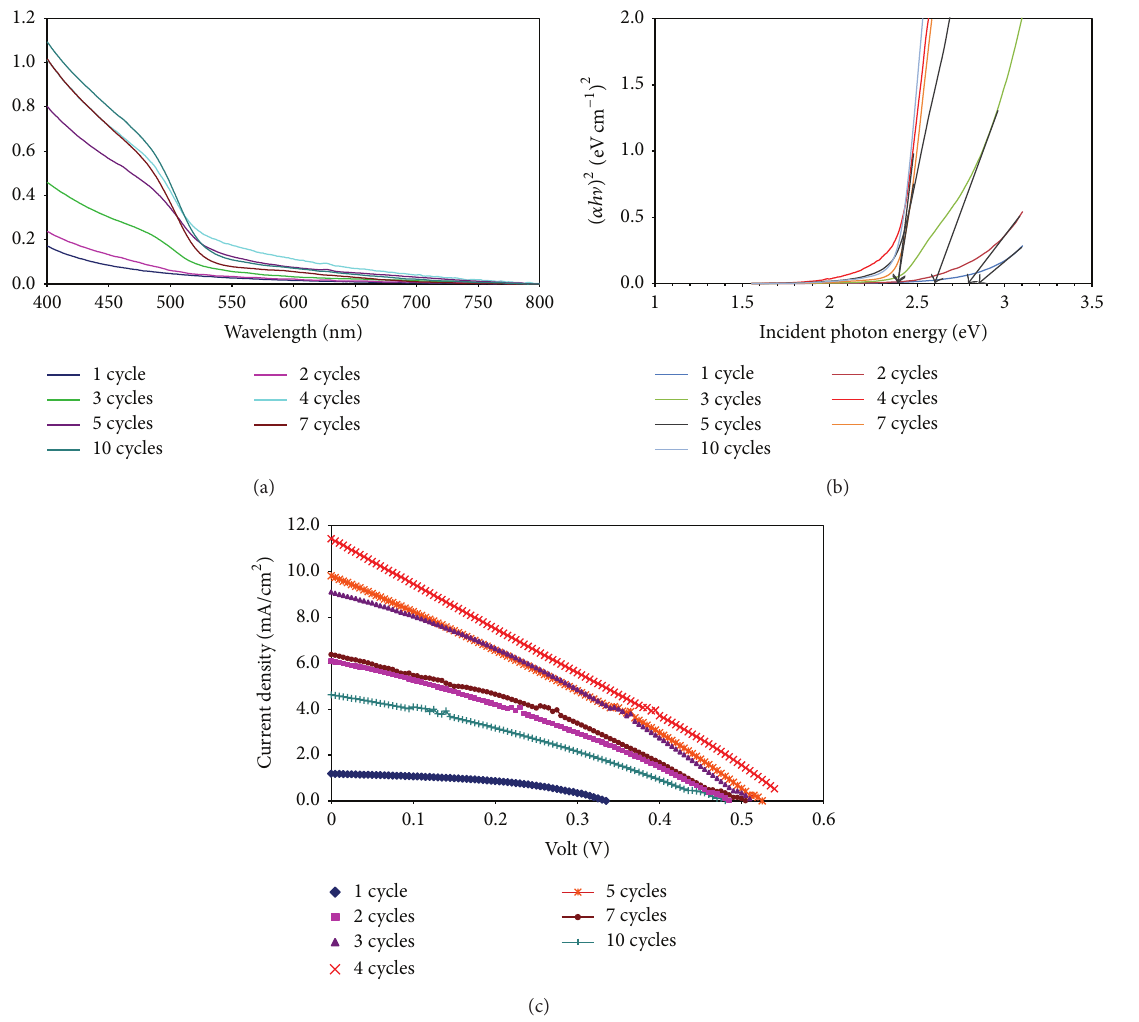
Figure 4: (a) UV-vis spectra, (b) Tauc plot, and (c) J-V curves of QDSSC for CdS QDs prepared using different number of SILAR